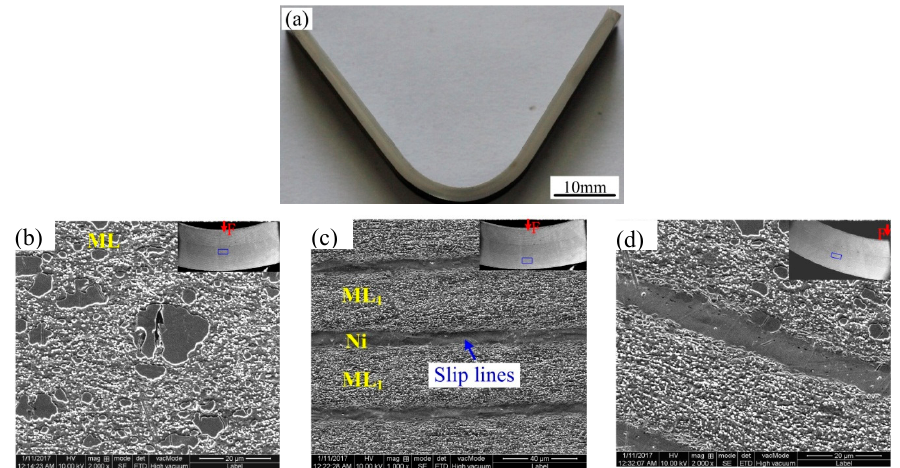
Figure 6. Macro-feature and SEM morphology of the bending specimen after bending to 136 degrees. ( a ) Macroscopic bending morphology, ( b – d ) SEM bending features.